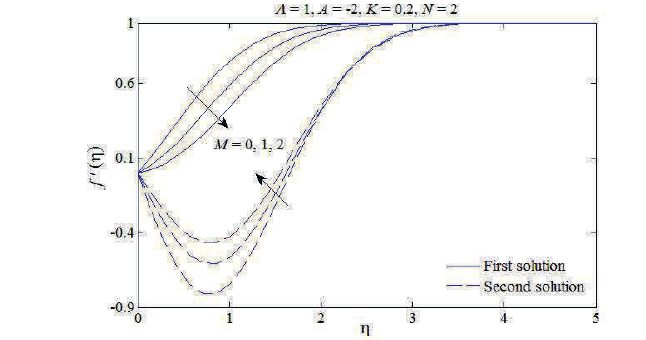
Fig. 3: The heat transfer rate − θ (cid:2) (0) with A for different values of M .